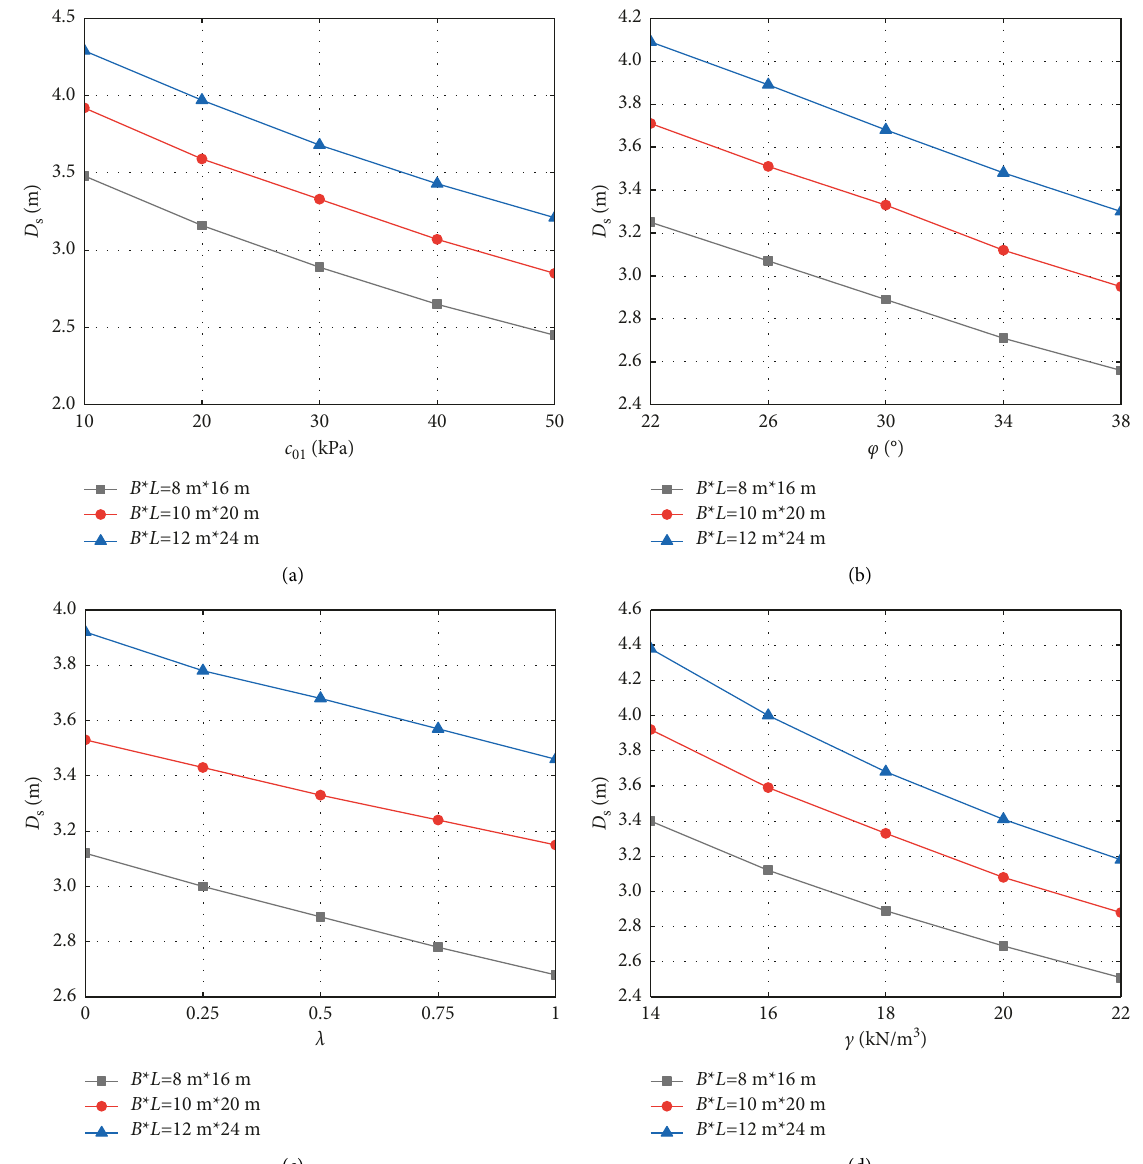
Figure 8: Effects of different linear Mohr–Coulomb parameters on critical safety thickness: (a) cohesion, (b) internal friction angle, (c) nonhomogeneity coefficient, and (d) unit